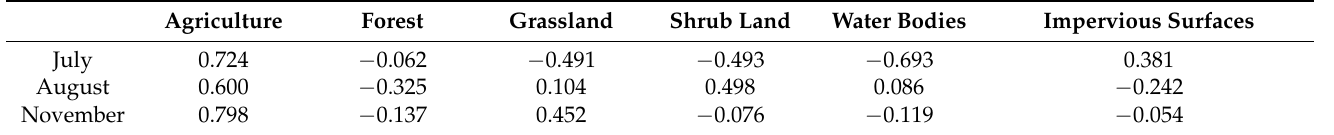
Table 2. Factor analysis results by type of landscape and water quality characteristics in the Maotiao River Basin (Gizhou province, SW China) in